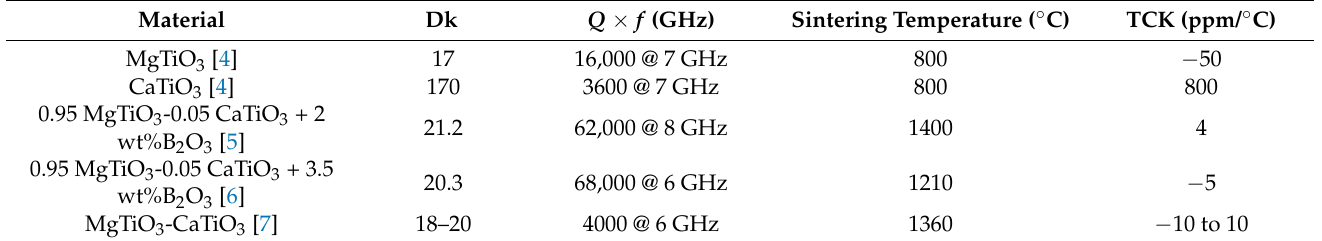
Table 1. The properties of selected MgTiO 3 -CaTiO 3 materials.